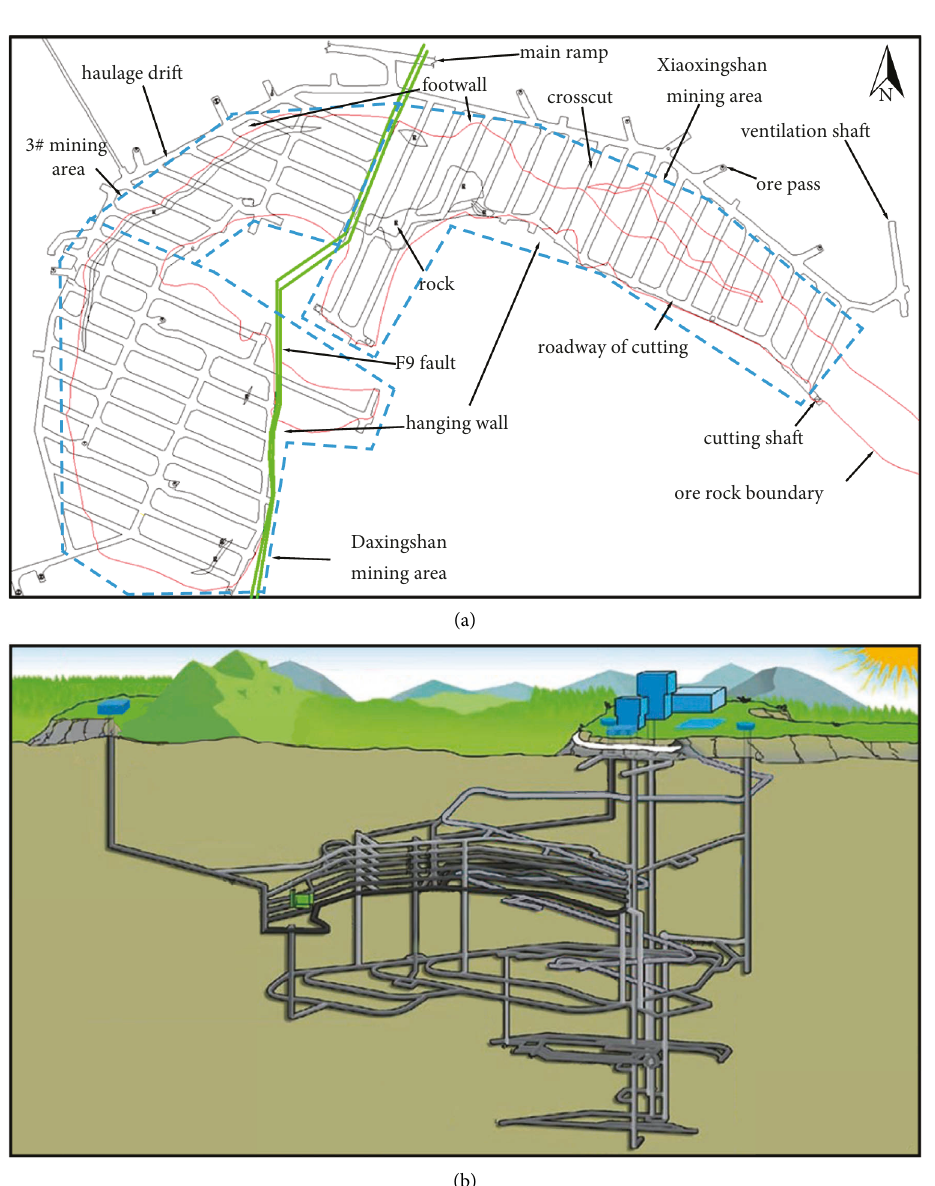
Figure 2: Layout of Xingshan iron mine (a) plan of typical sublevel layout (b) schematic diagram of shaft and roadway positions of Xingshan iron